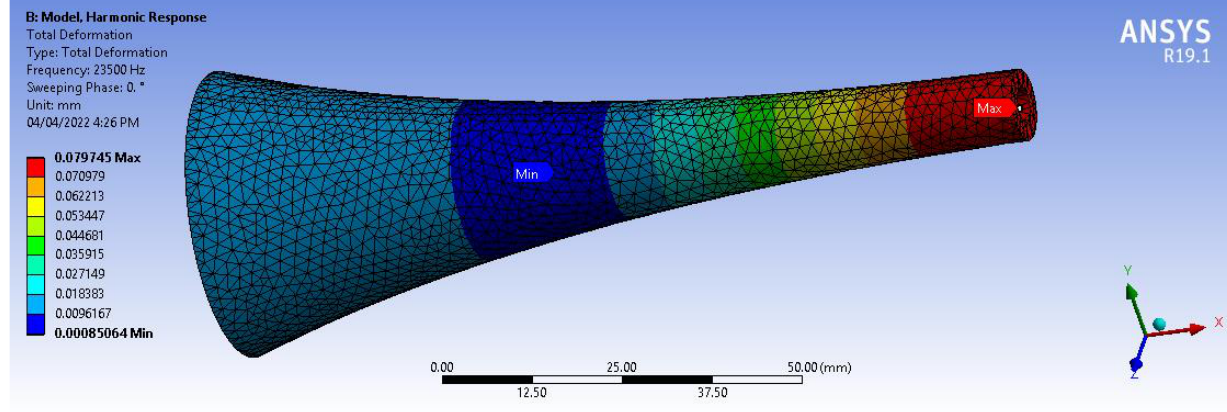
Figure 7 . Variation of vibration amplitude along the axial length of titanium catenoidal